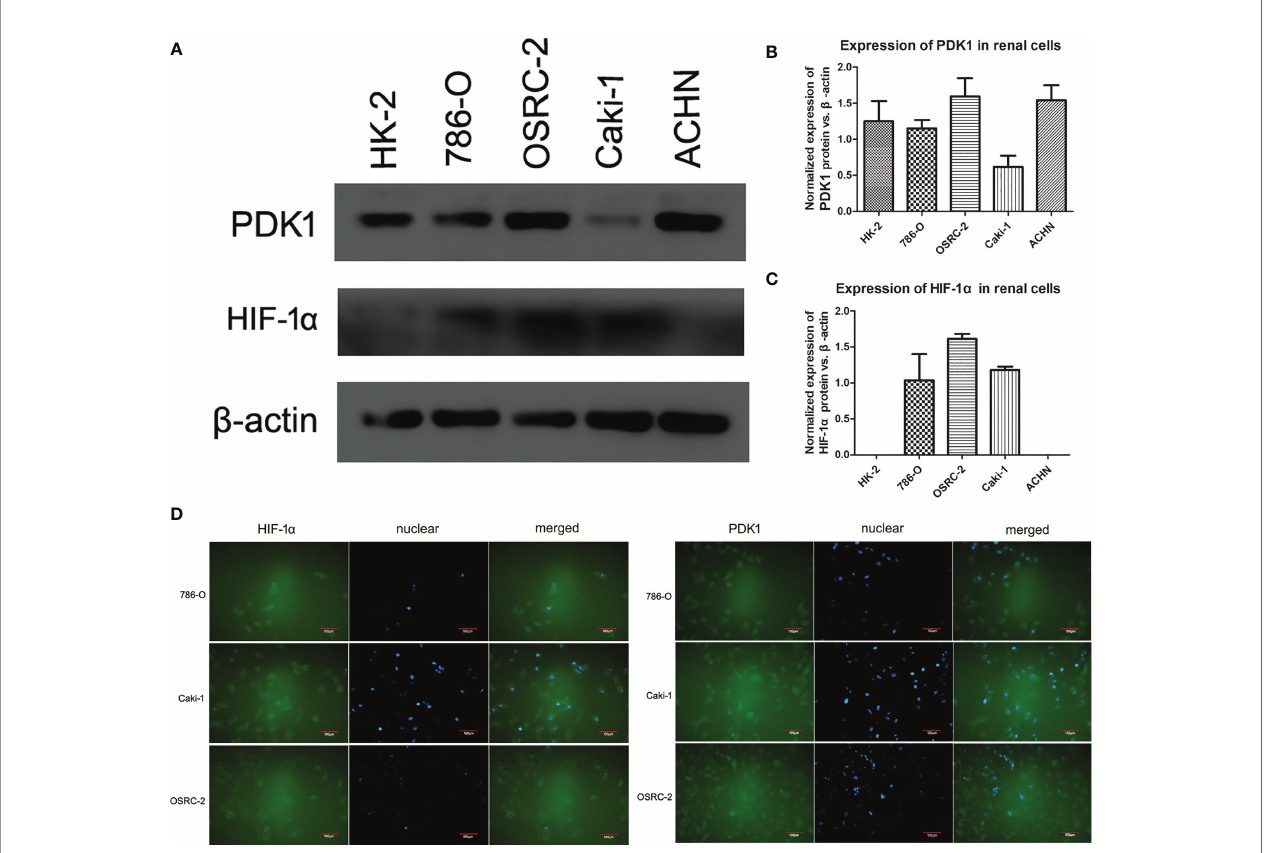
FIGURE 2 | Expression and location of HIF-1 a and PDK1 in renal cell lines. (A – C) HIF-1 a and PDK1 expression at the protein level in various cell lines (HK-2, 786- O, OSRC-2, Caki-1, and ACHN) was con fi rmed by western blot. b -actin was regarded as the reference. No expression of HIF-1 a was observed in HK-2 and ACHN cells. PDK1 expression was sharply higher in ACHN and OSRC-2 cells than in HK-2, 786-O, or Caki-1 cells. (D) Using immuno fl uorescence analysis, the expression of HIF-1 a and PDK1 was located in both the cytoplasm and cell nucleus (green color). The locations were almost the same in 786-O, Caki-1, and OSRC-2